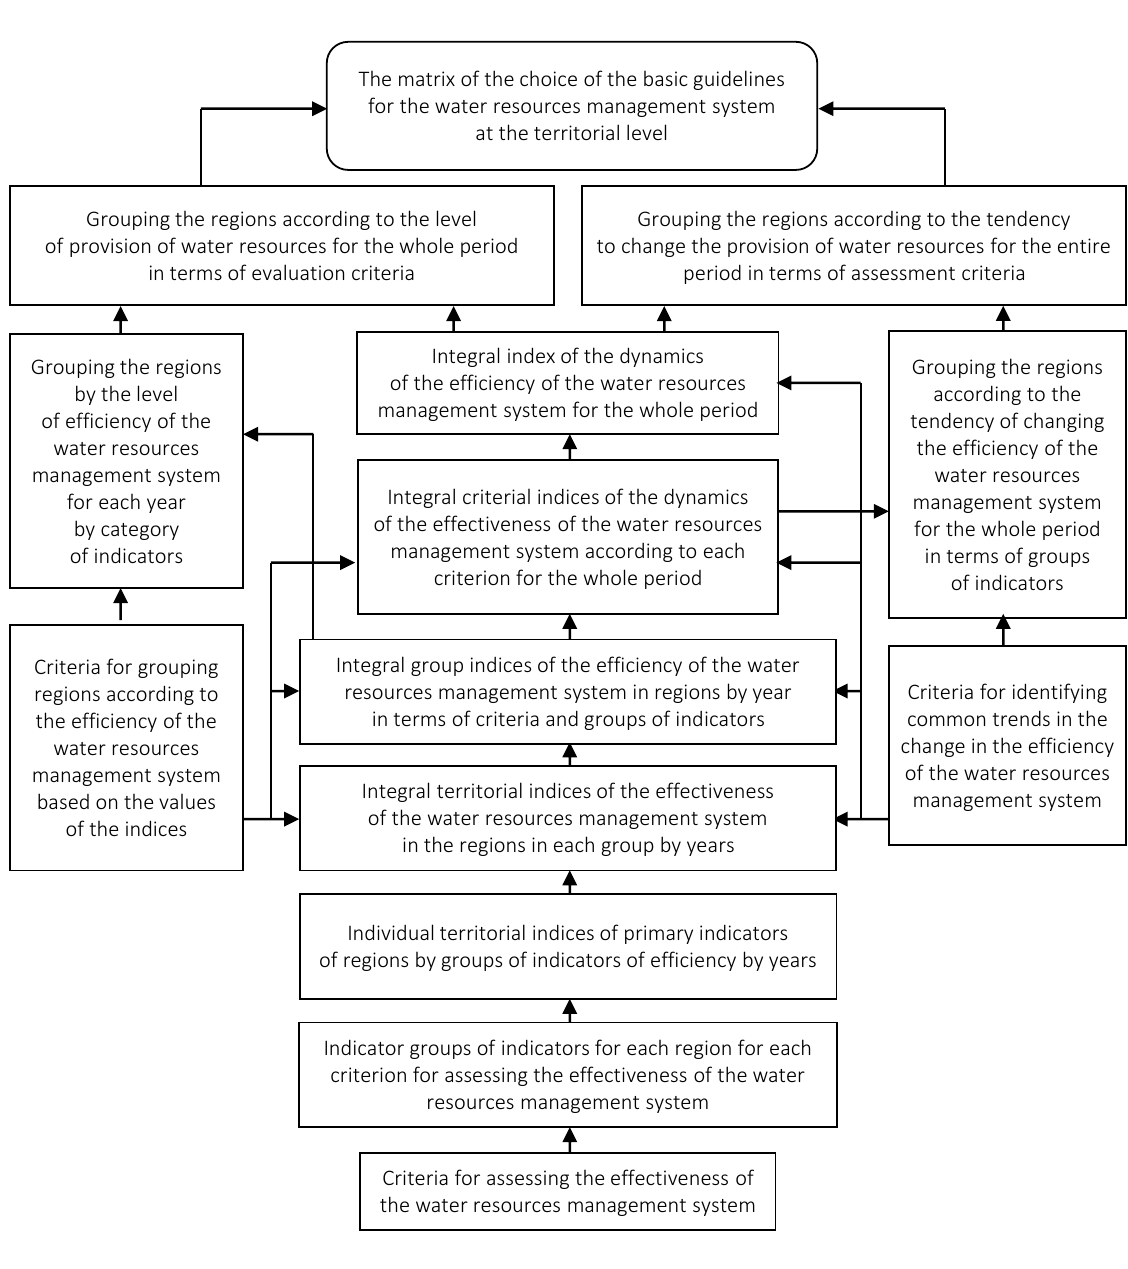
Figure A1. Algorithm for assessing the effectiveness of the water resources management system at the territorial